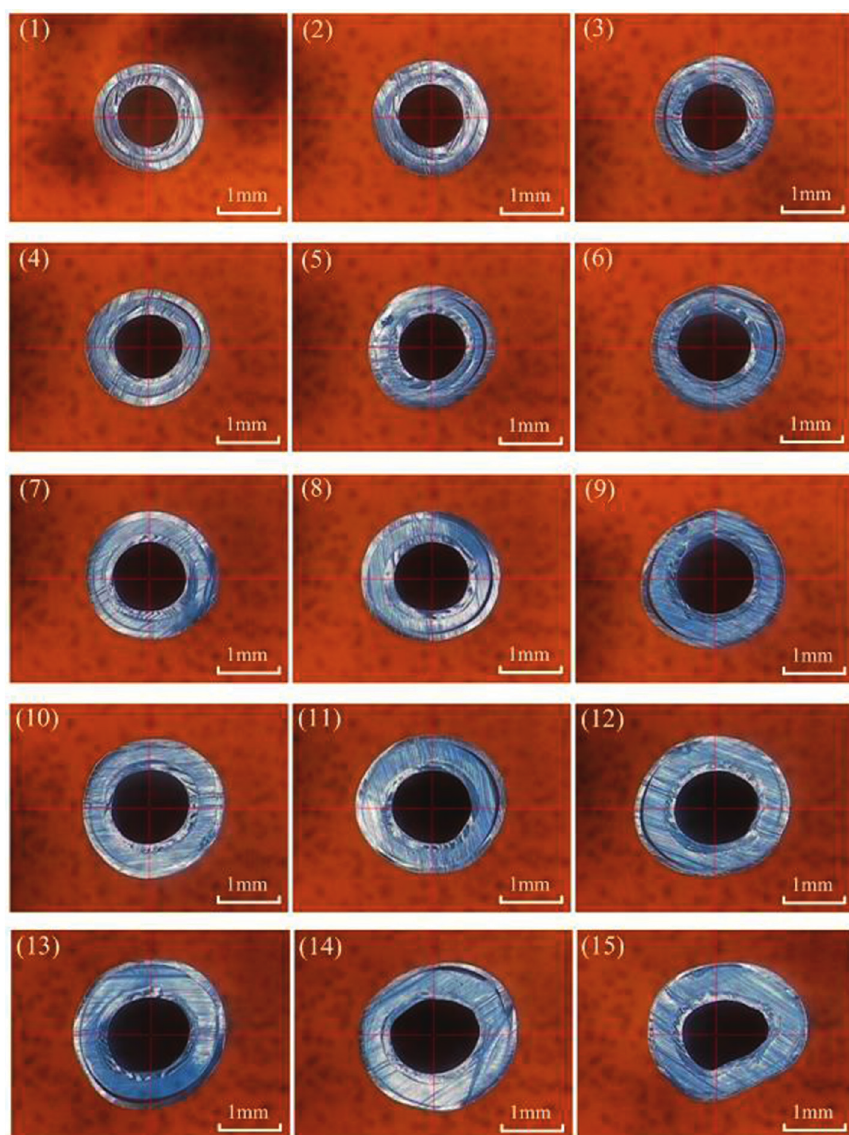
Figure 11: Graphics of cross sections of catheters at different screw speeds ( N N z 4 � 12 r/min, (e) N z 5 � 14 r/min, (f) N z 6 � 16 r/min, (g) N z 7 � 18 r/min, (h) N z 8 � 20 r/min, (i) N z 9 � 22 r/min, (j) N z 10 � 24 r/min, (k) N z 11 � 26 r/min, (l) N z 12 � 28 r/min, (m) N z 13 � 30 r/min, (n) N z 14 � 32 r/min, and (o) N z 15 � 34